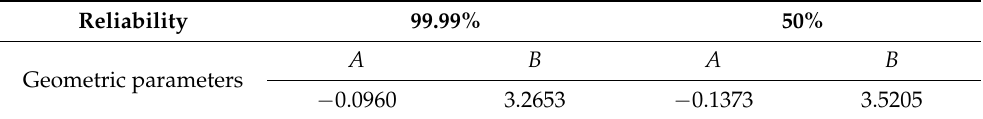
Table 4. Estimated geometric parameters of HY-type sucker rod.